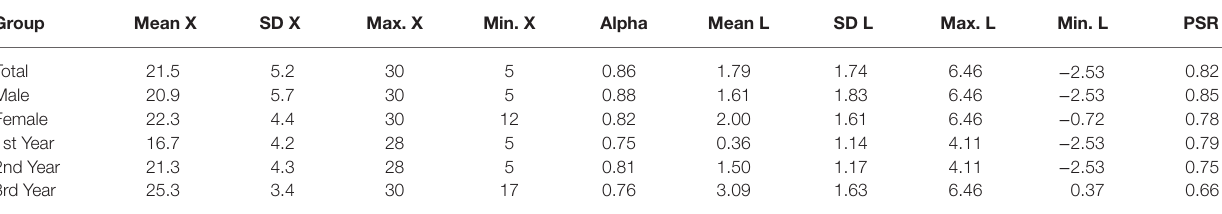
TABLE 9 | Contextual information. Descriptive statistics of the participants’ scores. Group